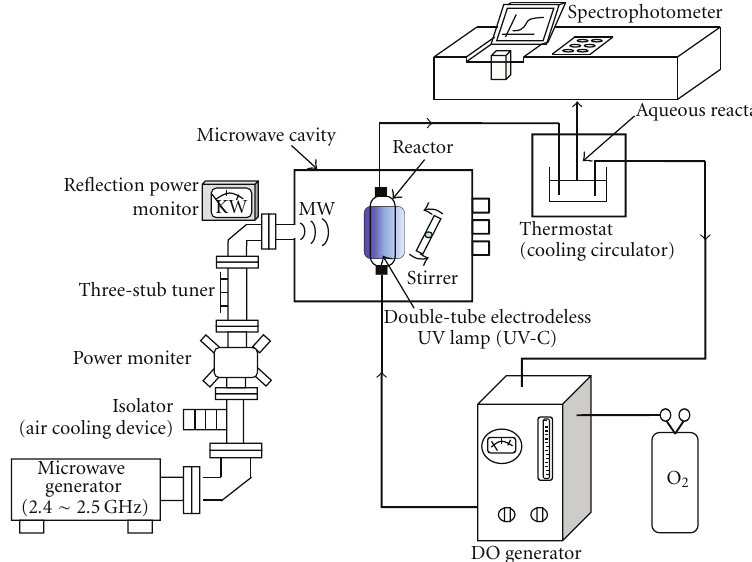
Figure 1: Schematics of the microwave/UV/DO TiO 2 photocatalytic degradation system.